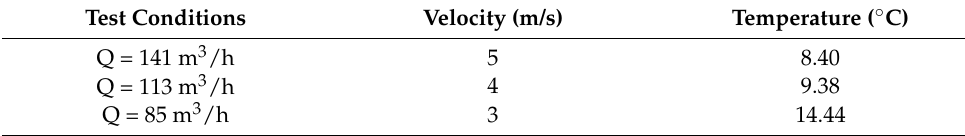
Table 3. Inlet boundary conditions for ventilation dilution simulations.